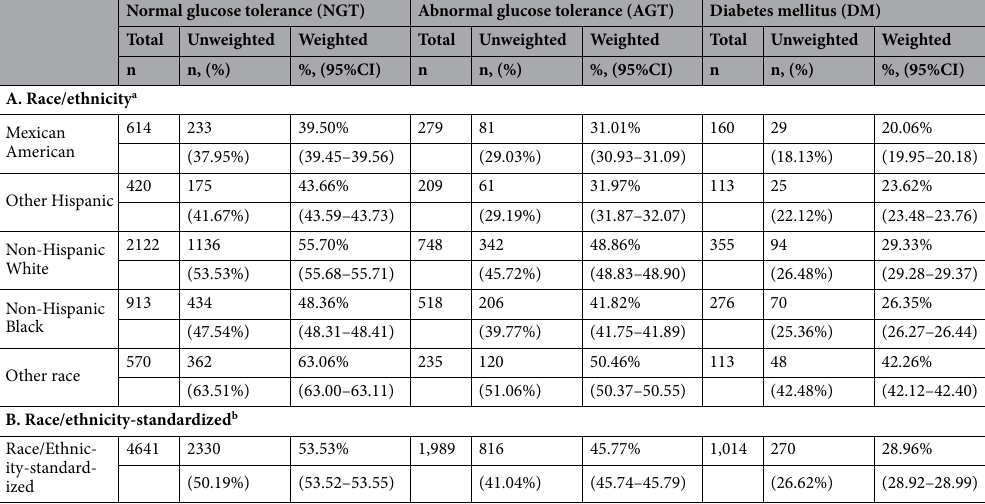
Table 4. The influence of race/ethnicity on seropositivity rates (%, with 95% confidence intervals [CI]) after hepatitis B vaccination, separated by glucose tolerance state. a P < 0.0001 for the weighted percent among five racial/ethnic groups in all three glucose tolerance states and for weighted percent among three states of glucose tolerance in five racial/ethnic groups. b P < 0.0001 for weighted percent among three states of glucose tolerance.